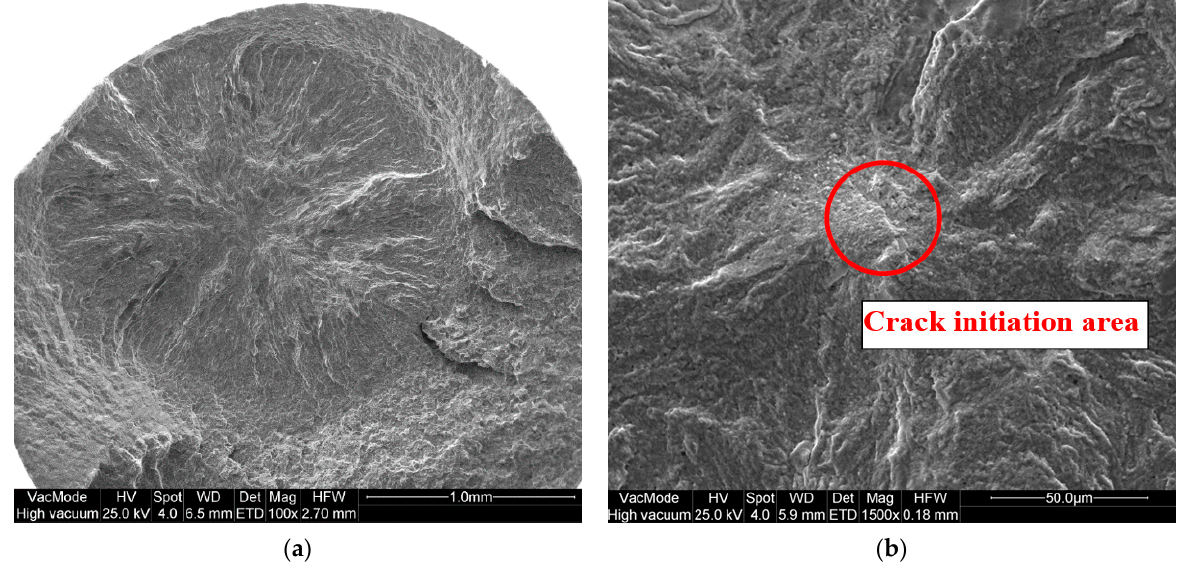
Figure 9. Internal matrix crack initiation of the welded specimen ( σ a = 480 MPa, N f = 9.36 × 10 6 ). ( a ) Fracture cross section; ( b ) crack initiation area.